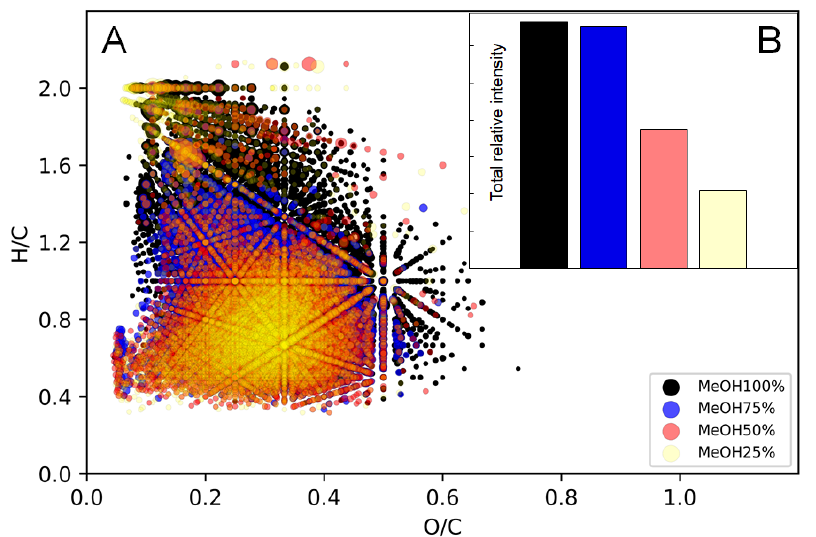
Figure 2. Van Krevelen diagrams for BP-Cx-1 fractions obtained by gradient extraction ( A ); summa- rized contribution of molecular components found in liver to the total intensity in mass-spectra of fractions ( B ).